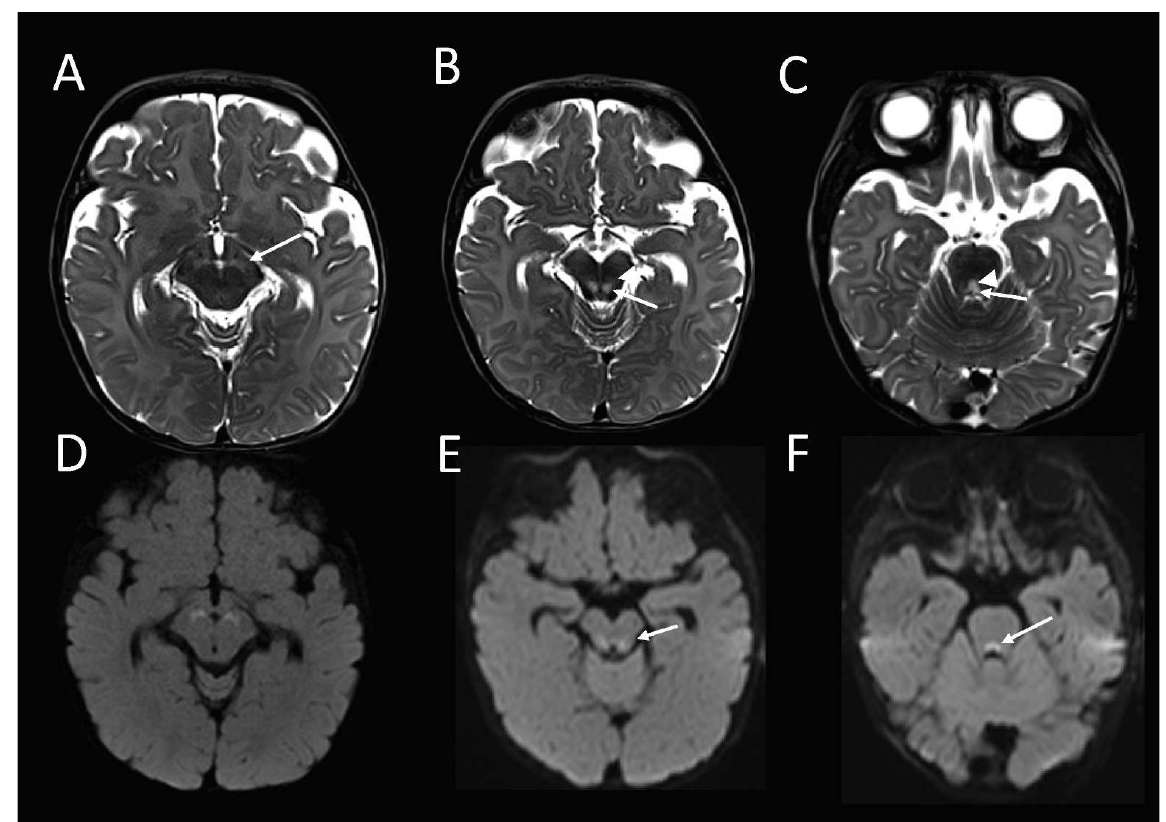
Figure 1. Brain MRI from the patient with compound heterozygous PYROXD2 variants at 4 ½ months . The axial T2-weighted sequence shows abnormally high signal in the ( A ) substantia nigra; ( B ) midbrain tegmentum, involving the central tegmental tracts (arrow), and the medial lemnisci (arrowhead) and; ( C ) upper dorsal pontine tegmentum, involving the tectospinal tracts (arrowhead) and middle longitudinal fasciculi (arrow), with corresponding restricted diffusion ( D – F ) on diffusion-weighted imaging.